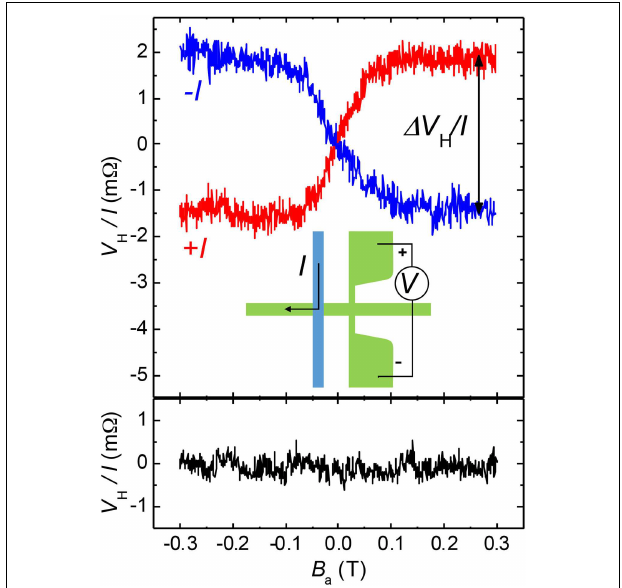
FIGURE 9 | Data showing the intrinsic inverse spin Hall effect. Sample: w C 6 . 0 µ m, L 2 . 83 µ m, I 1 mA, T 1 . 8 K. Magnetic field B a is applied = = = = along the x . Red trace: I positive. Blue trace: I negative. ˆ V H ( B a > 0 . 2 T) V H ( B a < 0 . 2 T) . The measurement geometry is shown 1 V H ≡ − in the inset Bottom panel: Control experiment described in the text. Spins are injected with orientation along the y axis, parallel with B R . There is no spin − precession and the spin Hall voltage is zero. Reproduced from Choi et al. [23].